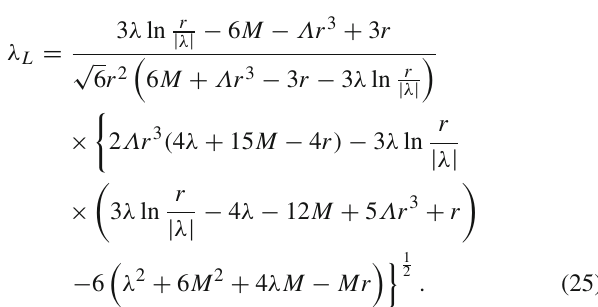
equation for stable circular